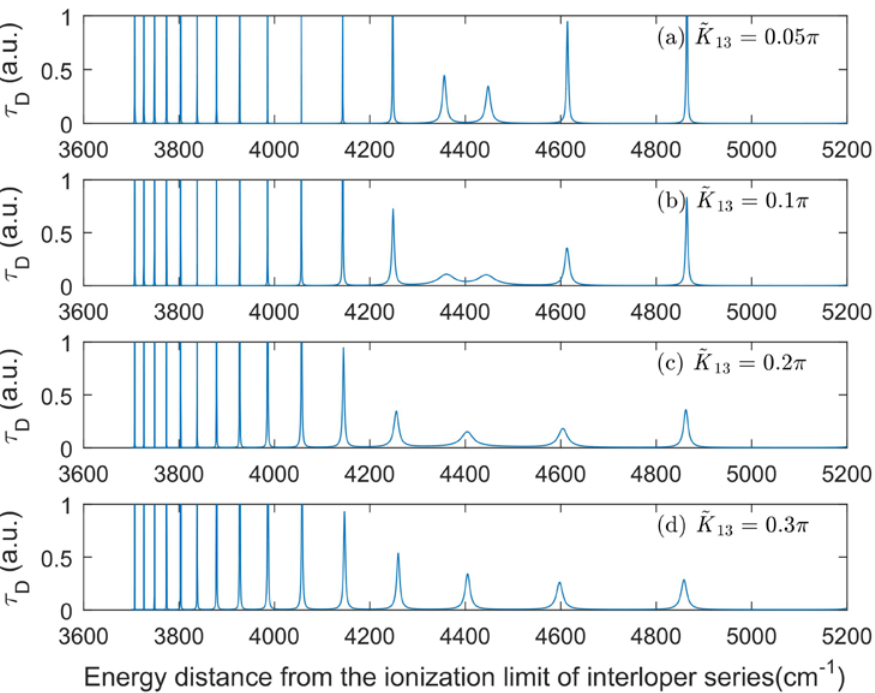
Figure 3. Disappearance of the transition of an interloper line into the structured background when examined by the time delay spectra (from [13]).